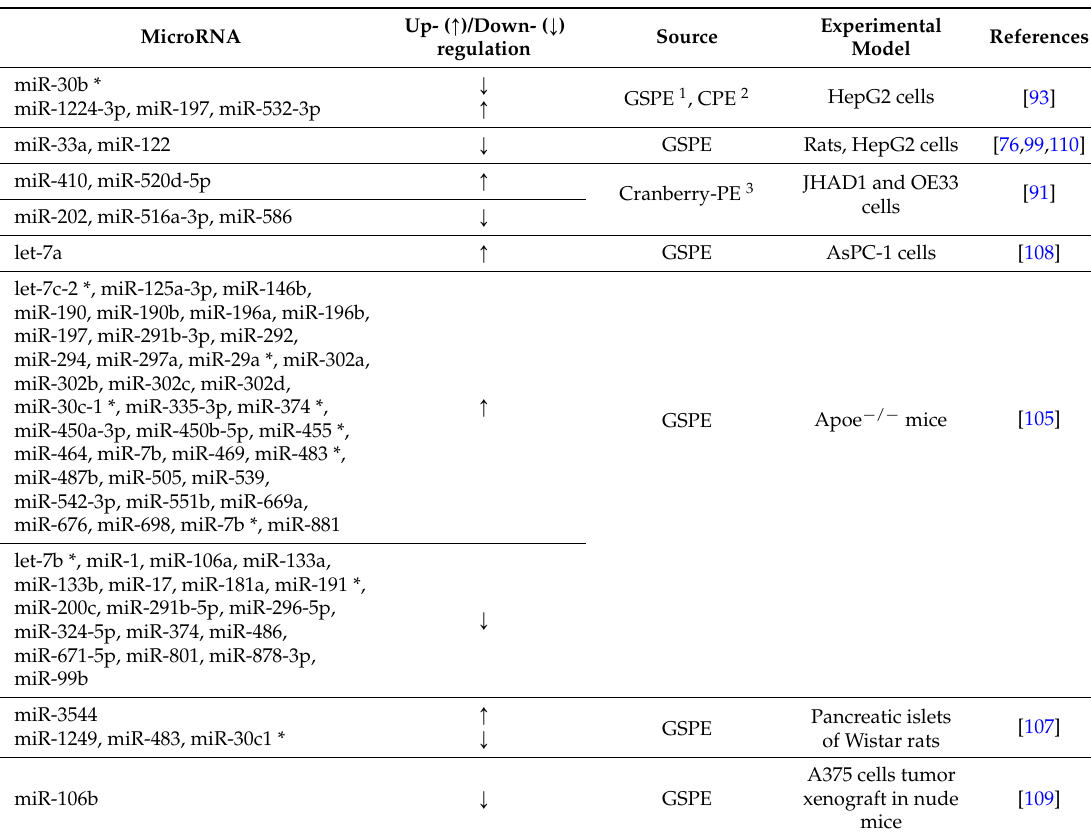
Table 2. List of miRNAs regulated by